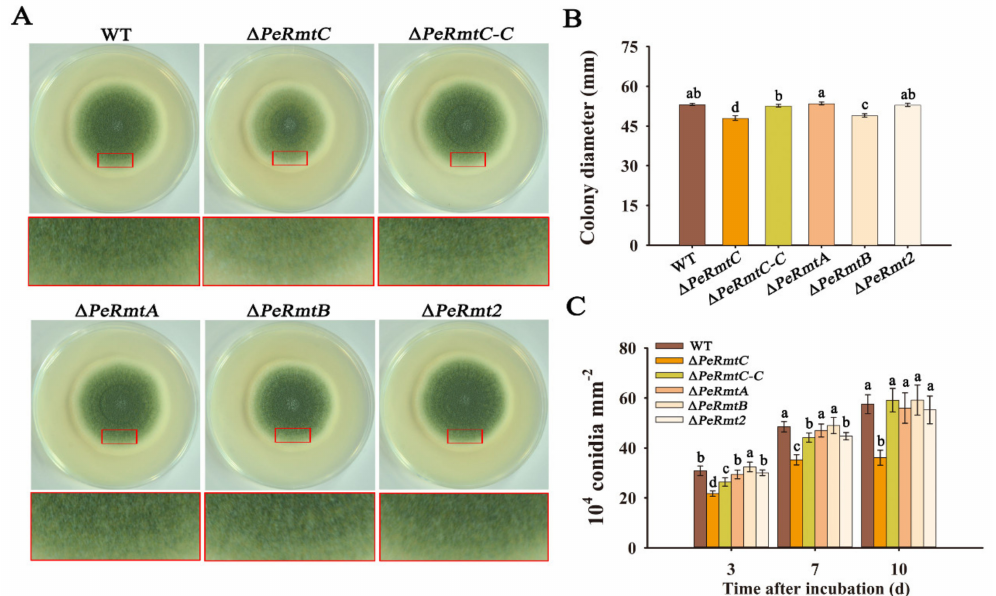
Figure 2. Effects of PeRmtC on growth and conidiation of P. expansum . ( A ) Colony morphologies of PRMTs deletion mutants on potato dextrose agar (PDA) after 7 d of incubation. Close-up views with red borders show the conidiation of corresponding strains. ( B ) Mean colony diameter of each strain after 7 d of growth. ( C ) Conidiation of each strain after 3, 7, and 10 d of incubation on PDA, respectively. The experiments were performed with three biological replicates. Columns with different letters are significantly different ( p <